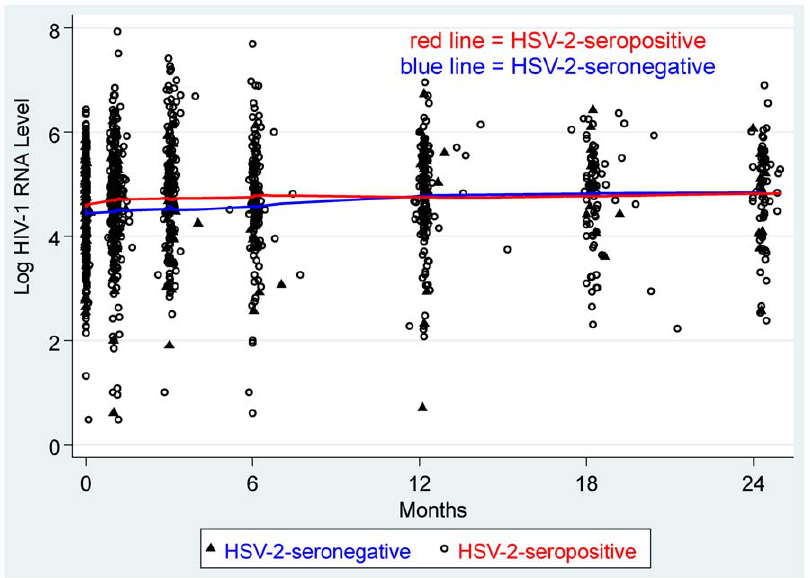
Figure 2. Scatterplot of Log 10 HIV-1 RNA Level Over Time, by HSV-2 Serostatus at Baseline. Points represent individual measures of log 10 HIV-1 RNA levels. Curves represent locally weighted smoothed curves of log 10 HIV-1 RNA levels over time, by HSV-2 serostatus. Time=months since delivery.